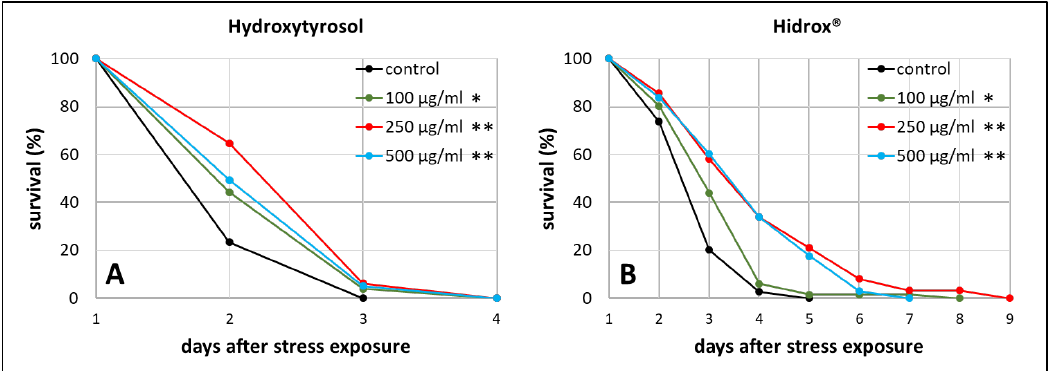
Figure 1. Heat stress resistance in the presence of HT and HD. At the third day of adulthood (day 1) wild type nematodes were exposed to heat stress at 37 °C for 3 h prior monitoring survival. The survival is plotted as the percentage of the initial population in the control group as well as in the HT ( A ) and HD ( B ) treated groups. Three biological replicates were combined with a total of ≥52 nematodes per treatment. Statistical significance was calculated by log-rank test. Differences compared to control were considered significant at p < 0.05 (*) and p < 0.001 (**).